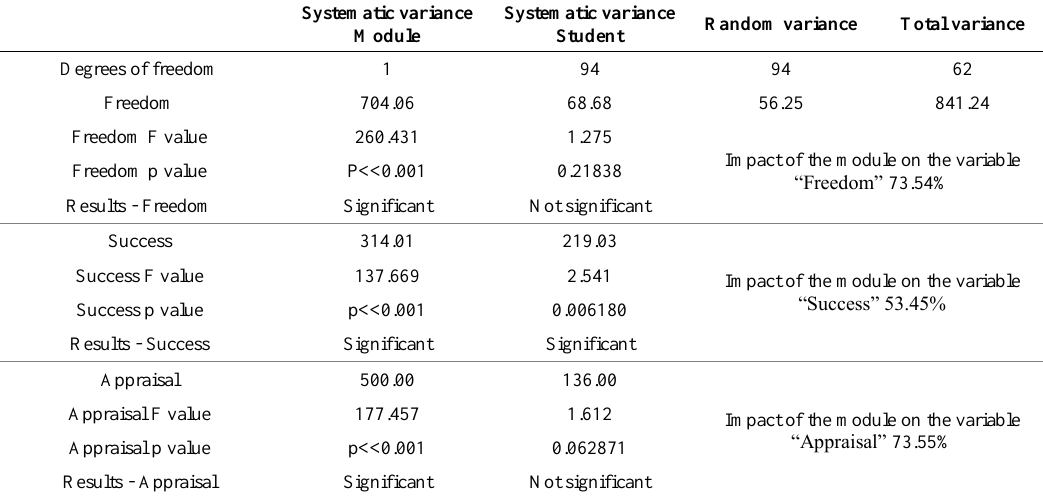
Table 8. Variance analysis - MOTIVATION (Freedom, Success, Appraisal, Communication, Cognition) Systematic variance